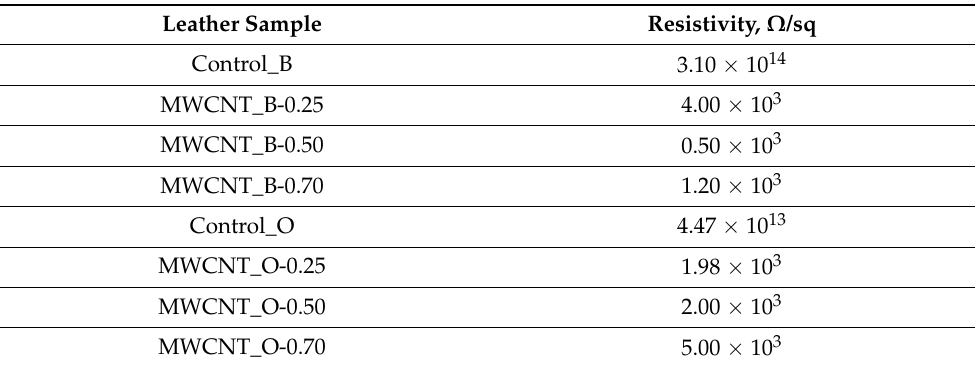
Table 2. Surface resistivity of the untreated and treated leathers with MWCNTs. Leather